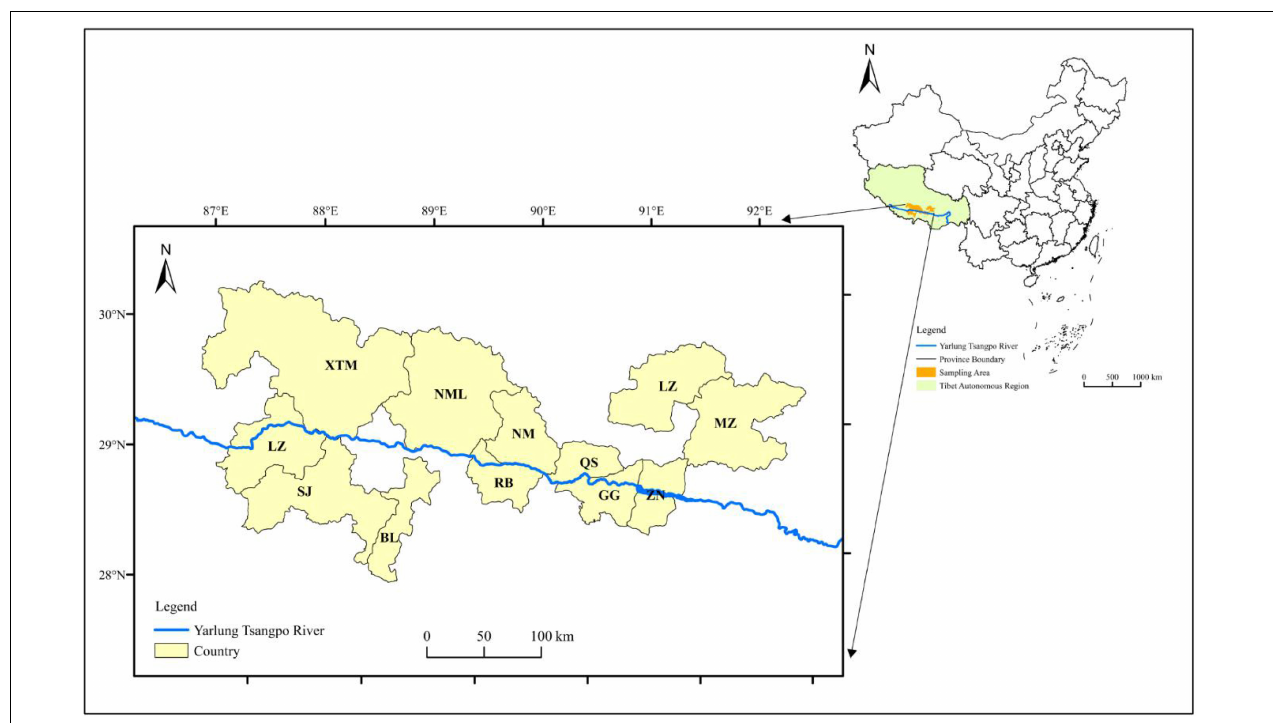
FIGURE 1 | Distribution of sample counties.